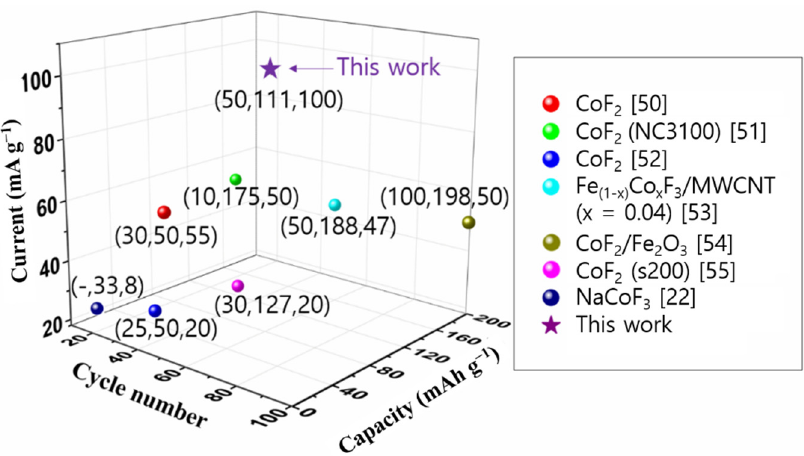
Figure 7. Cycle number vs capacity vs current of cobalt fluoride-based materials in LIB. The repre- sented points are based on previous studies (x,y,z x: cycle number y: capacity, z: current).